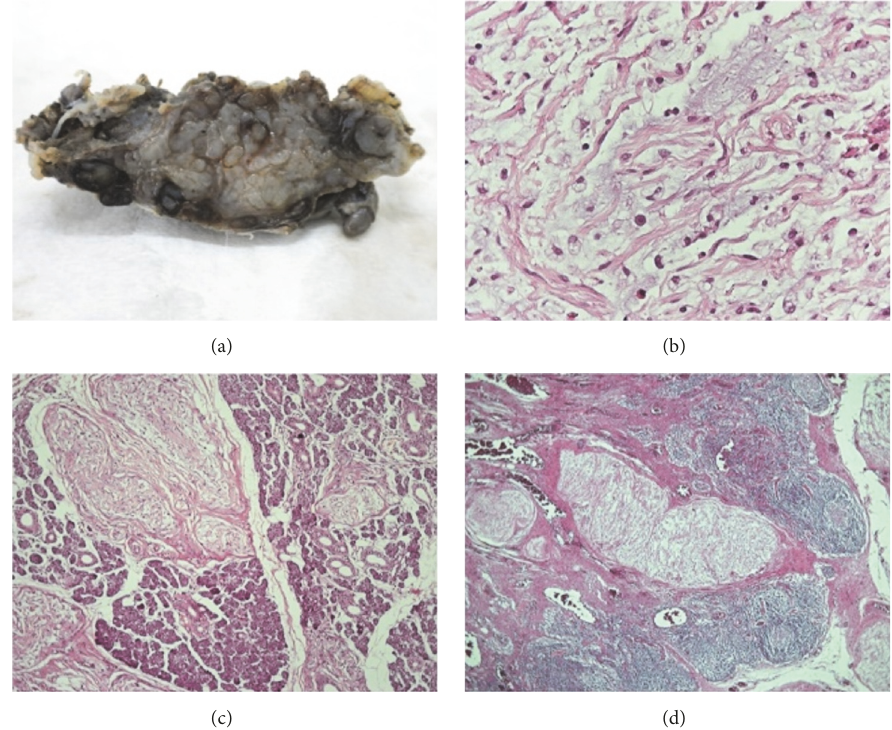
Figure 3: Nodular gray-white soft mass (a) consisting histologically of relatively uniform spindle cells with pointed ends (b), infiltrating the parotid (c), and the hilum of a lymph node (d) ((b) HE × 400; (c) HE × 100; (d) HE × 40).